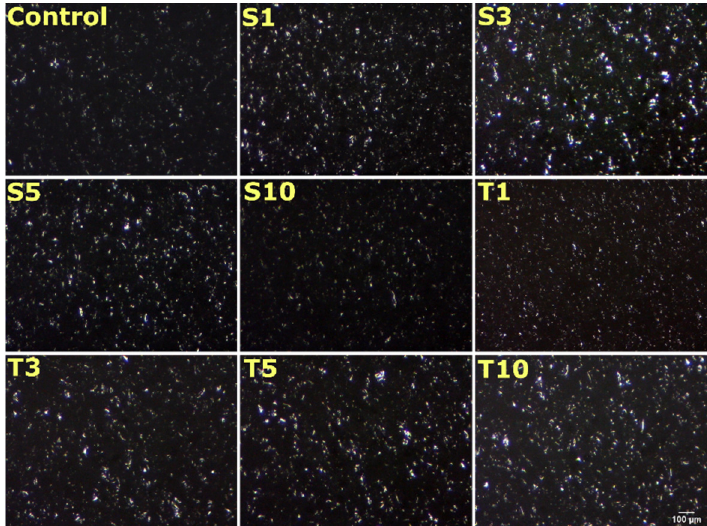
Figure 3. Surface topology images of oleogels representing the presence of globular structures. Scale bar: 100 µm. ( S1–S10 : Increasing amount of SPAN-80 content; T1–T10 : Increasing amount of